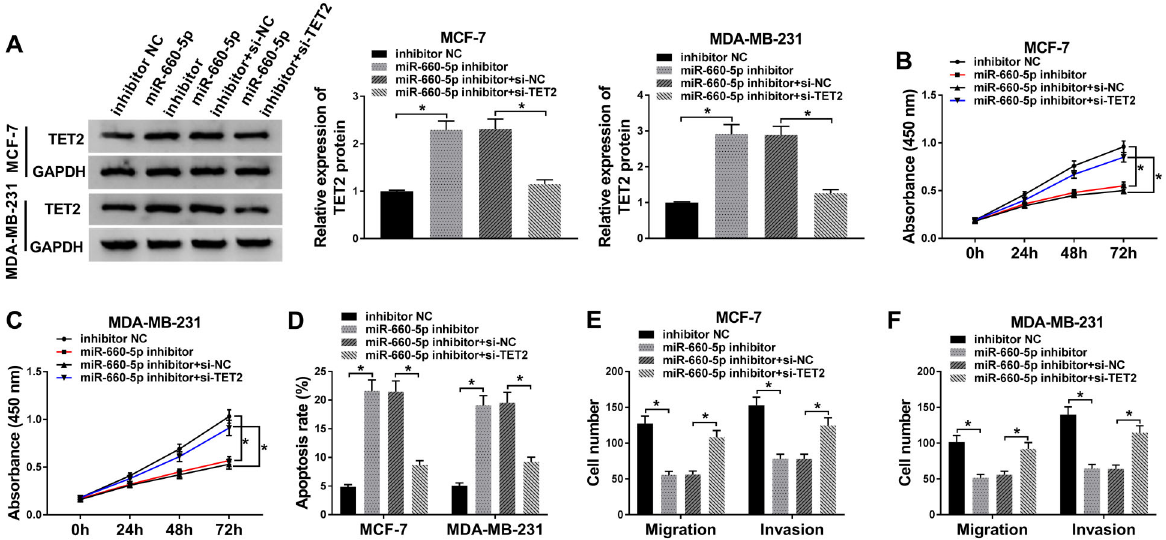
Figure 5. MCF-7 and MDA-MB-231 cells were transfected with inhibitor negative control (NC), miR-660-5p inhibitor, or miR-660-5p inhibitor plus si-NC or si-TET2. A , The expression of TET2 was determined in breast cancer (BC) cells by western blot after transfection for 24 h (n=3). B and C , CCK8 assay was carried out to detect cell proliferation in BC cells (n=6). D , Cell apoptosis was assessed in BC cells by fl ow cytometry after transfection for 72 h (n=3). E and F , Cell metastasis was evaluated in BC cells by transwell migration and invasion assays after transfection for 24 h (n=3). Data are reported as means ± SD. *P o 0.05 (ANOVA).